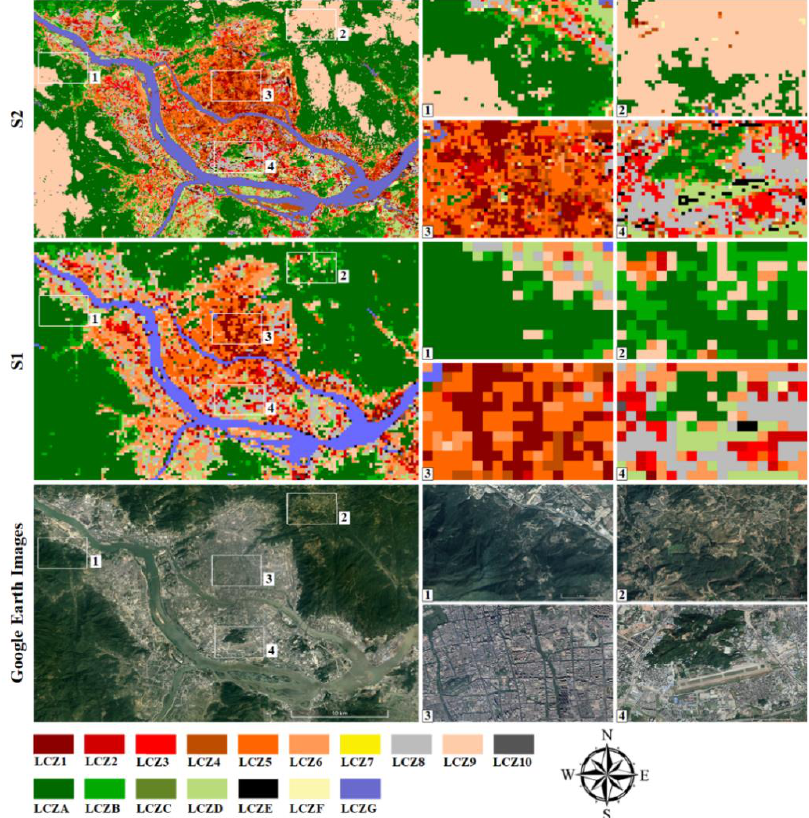
Figure 8. Comparison of LCZ mapping results under two schemes (Scheme 1 and Scheme 2): A case study of Fuzhou. The enlarged results of each scheme for the four subset areas (Box 1, 2, 3, and 4) are presented. Google Earth images of each region are also presented.